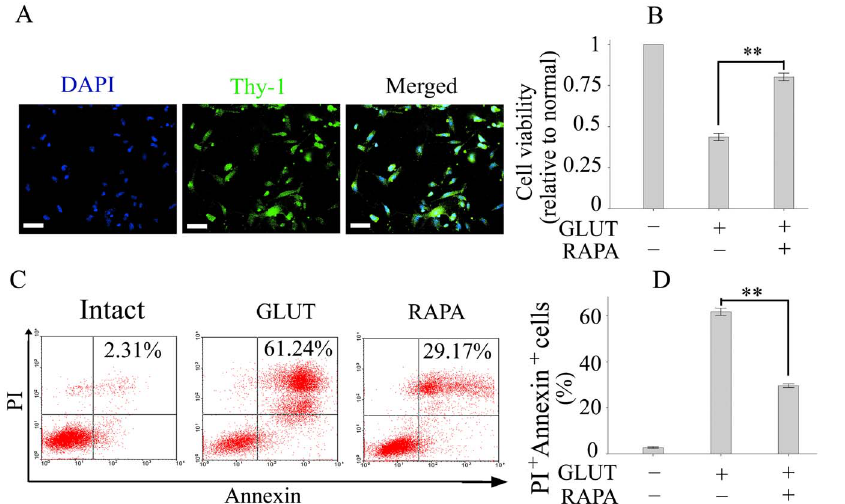
Figure 5. Rapamycin inhibited apoptosis in glutamate-injured primary RGCs. (A): Representative images of Thy-1 immunostaining (green) in primary RGCs. (B): The cell viability of primary RGCs was measured by MTT assay. (C, D): The numbers of PI + Annexin + cells, indicating apoptosis, were detected by flow cytometry. Values are presented as the mean 6 SEM of 3 replicates, and experiments were repeated at least 2 times with similar results. ** p , 0.01. Abbreviations: GLUT, glutamate; RAPA, rapamycin; PI, propidium iodide.